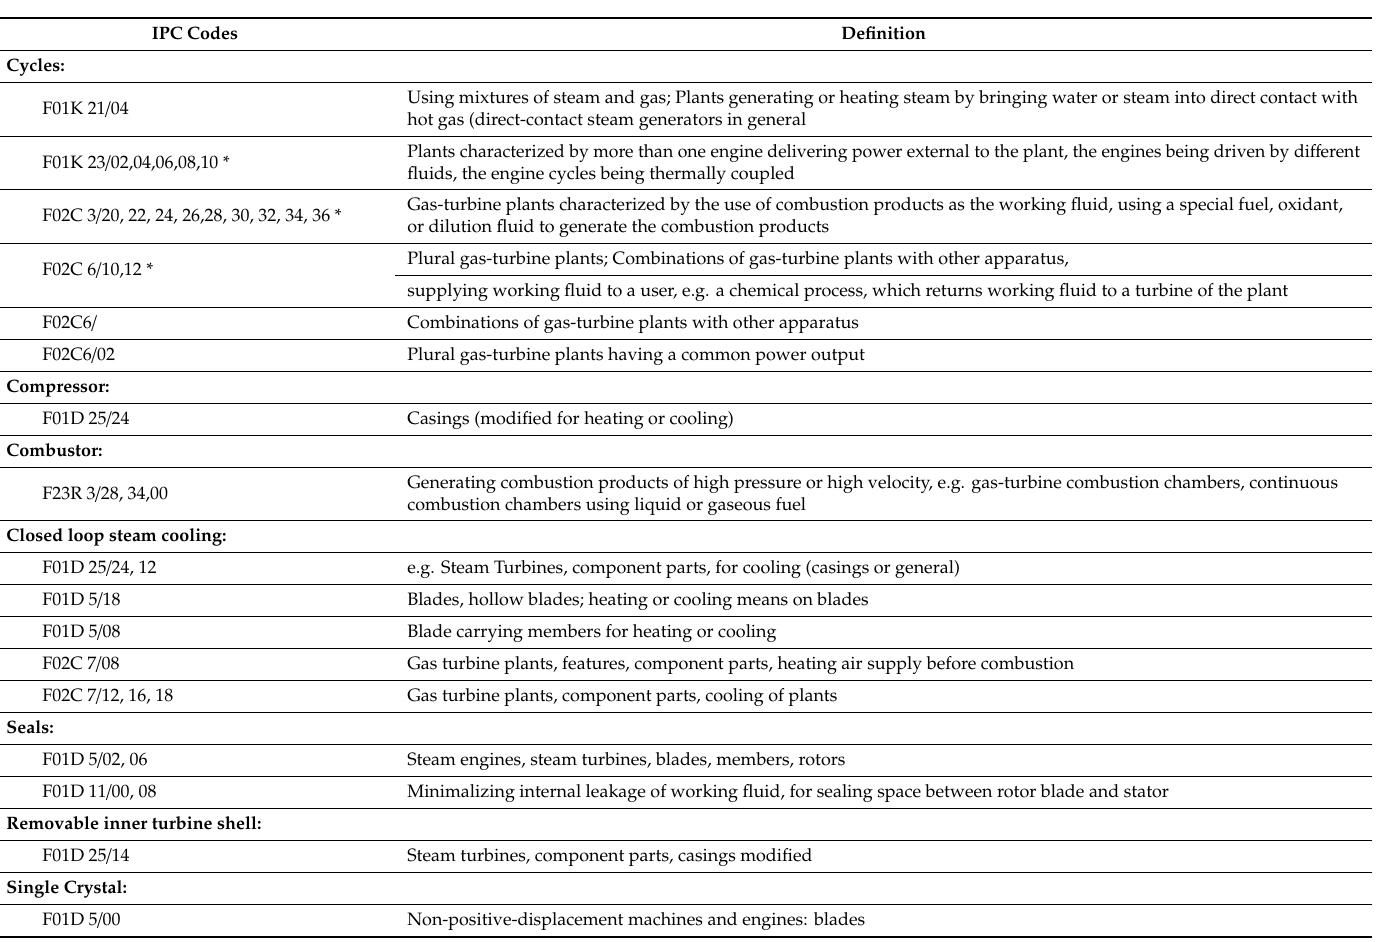
Table A1. International Patent Classification (IPC) codes used in this study to identify advanced NGCC technology, and a short description of